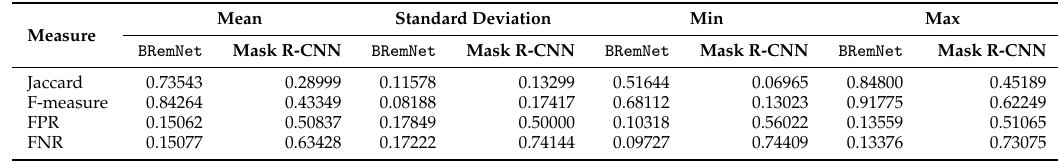
Table 3. Mask segmentation metrics in the frames with min Jaccard.